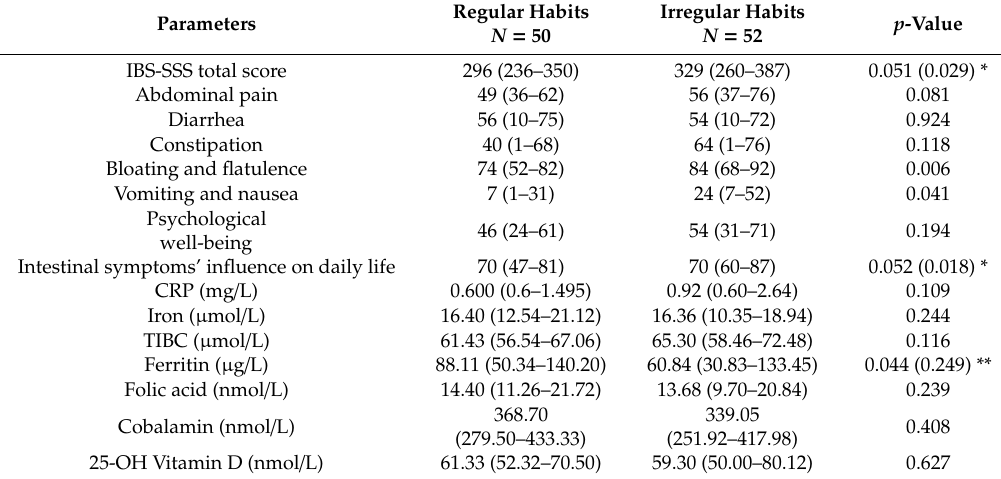
Table 4. Di ff erence in gastrointestinal symptoms and laboratory analyses in regard to regular and irregular dietary habits during